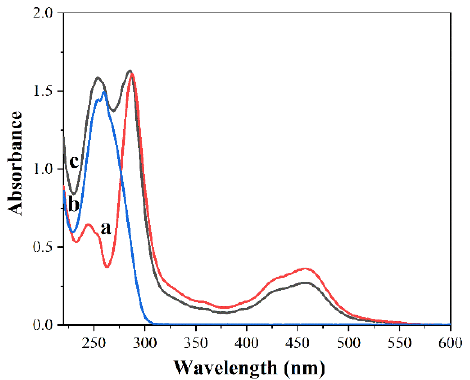
Figure 3. The UV–vis spectrum of the solution Ru(bpy) 32+ -NHS ester labeled the amino probes. Curve a is the spectrum of Ru(bpy) 32+ -NHS ester. Curve b is the spectrum of amino probes. Curve c is the spectrum of Ru(bpy)32+ labeled signal probes.